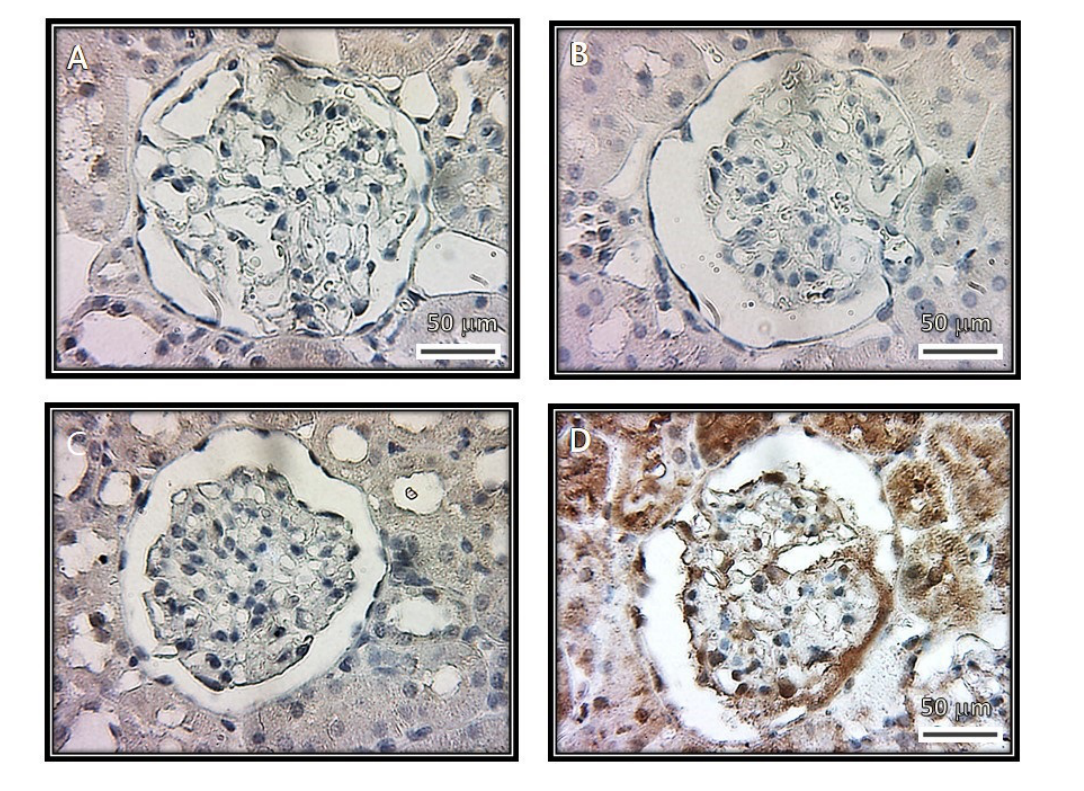
Figure 8. Immunohistochemistry of representative rat renal cortexes with the TNF α antibody. The images show glomeruli from ( A ) control, ( B ) kidneys from rats that were injected with saline solution and ( C ) kidneys from rats that received serum from healthy subjects. The images in these three panels show a negative stain. ( D ) Kidneys from rats that received serum from patients having collapsing glomerulopathy. In this panel, there is a positive stain.